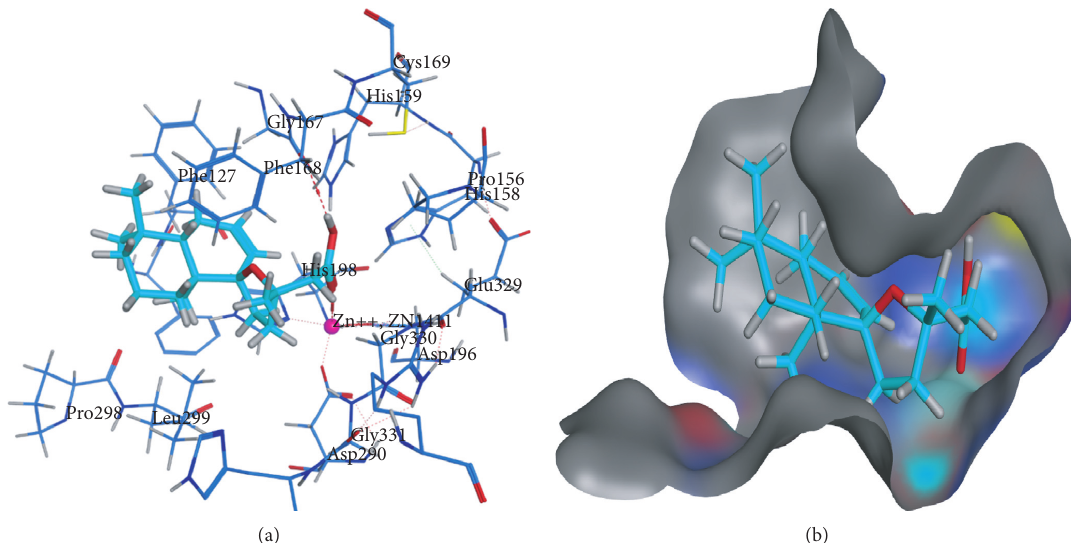
Figure 6: (a) 3D structure of compound 1 docked into the active site of HDAC (b) Mapping surface showing compound 1 occupying the active site of